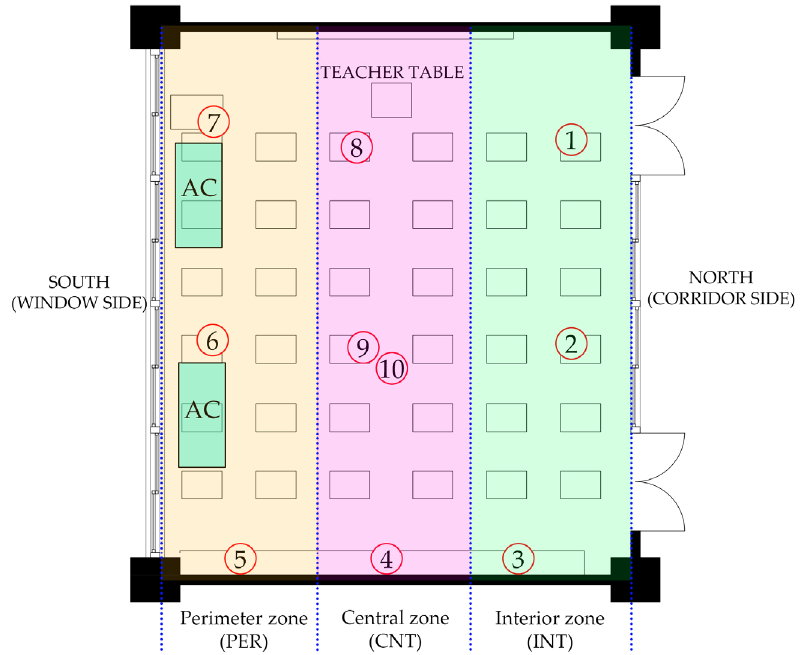
Figure 3. Measurement points and zoning.